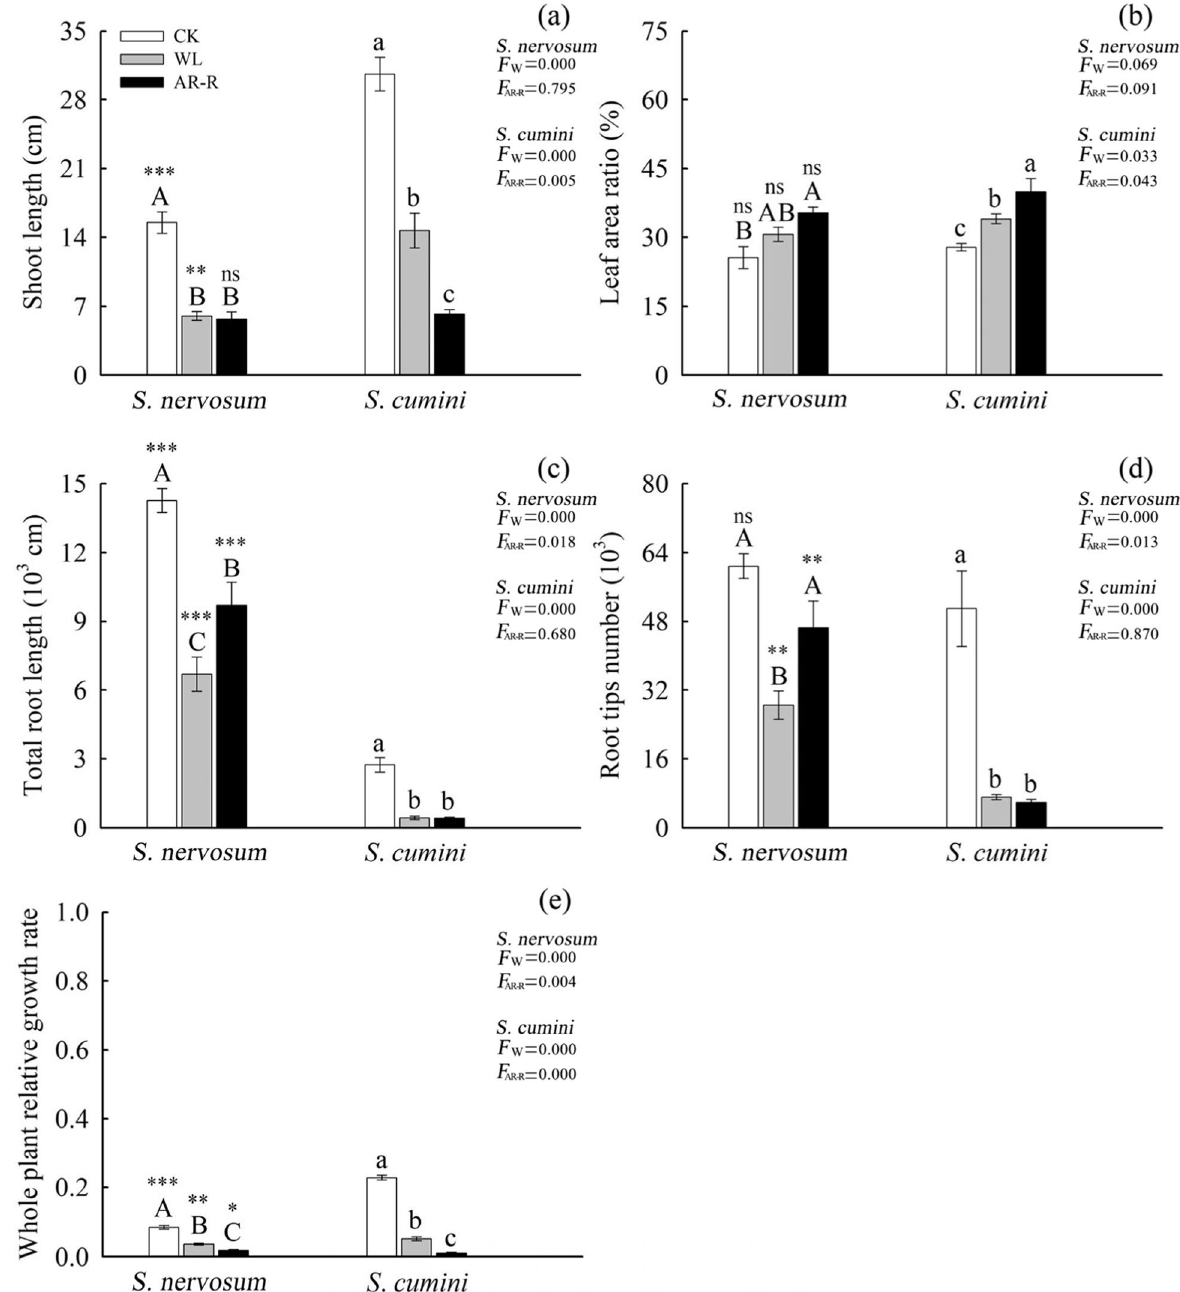
Fig. 3 Shoot length ( a ), leaf area ratio ( b ), total root length ( c ), root tip number ( d ), and whole-plant relative growth rate ( e ) in S . nervosum and S . cumini saplings, as affected by waterlogging with or without adventitious root removal. Treatment: CK, well-watered; WL, waterlogging; AR-R, adventitious root removal. F W , waterlogging effect; F AR-R , adventitious root removal effect. Data presented are means different letter within the same species group indicate significant differences at p <0.05 by analysis of variance (ANOVA). Asterisks above bars denote statistically significant differences between the species according to independent-samples t test. ns, p >0.05;